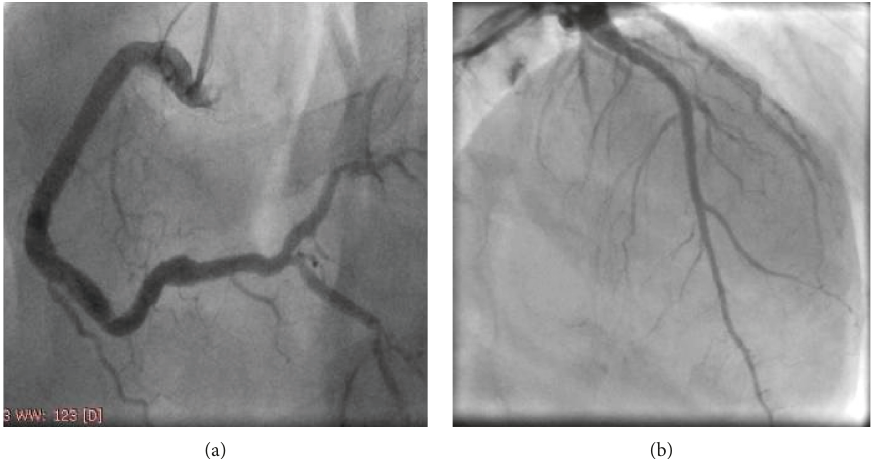
Figure 3: Final angiographic result. Both right coronary artery (a) and left anterior descending coronary artery (b) showing good an- giographic result, with TIMI 3 flow and no residual